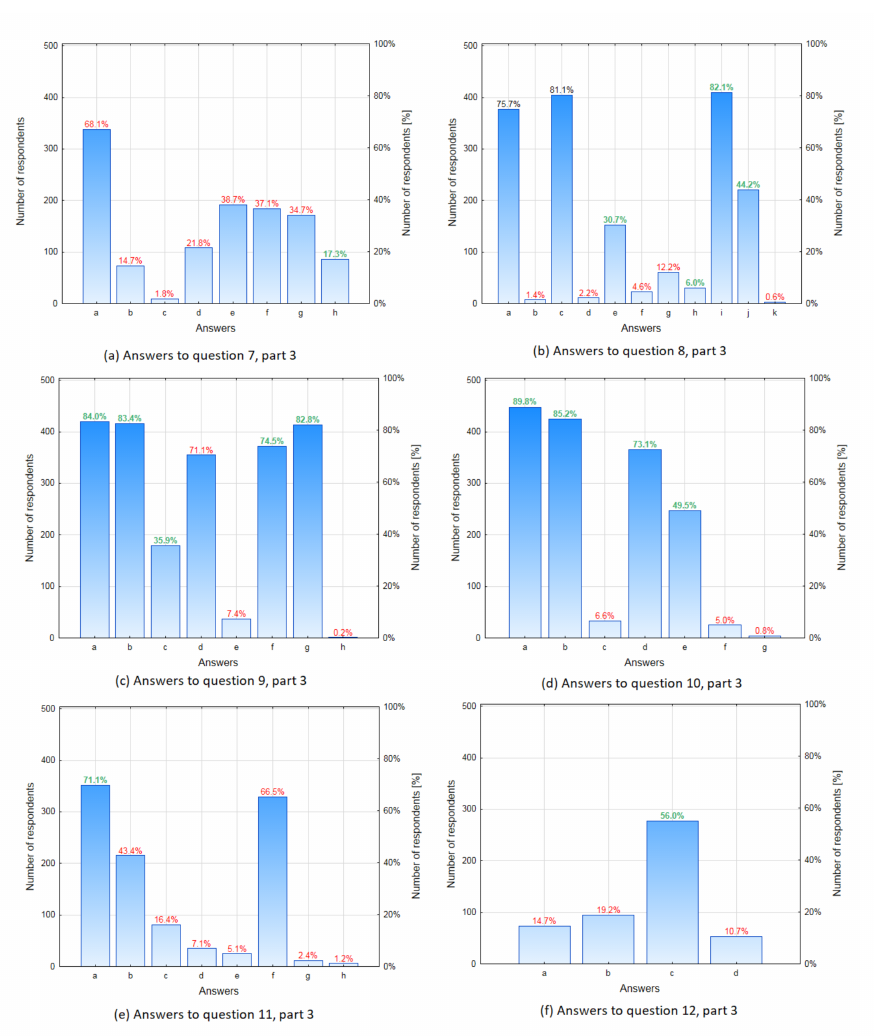
Figure A2. ( a – f ) Answers to first questions 7–12 from part 3 of the survey. The most recommended answers are marked green, and other answers are marked